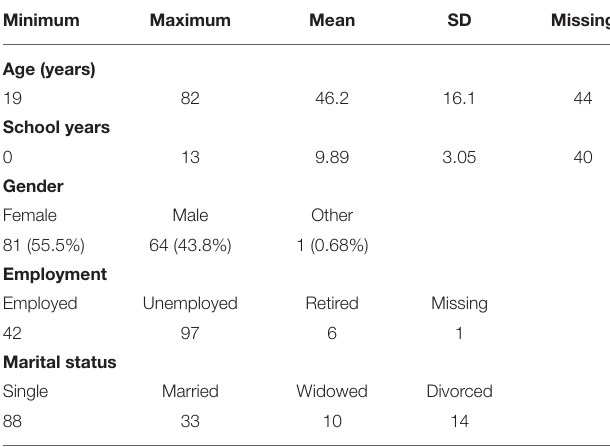
TABLE 1 | Demographic